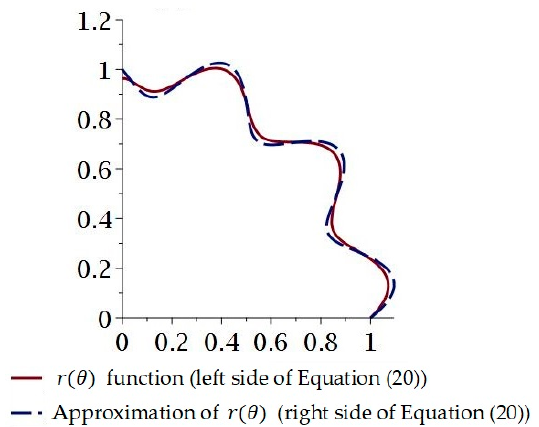
Figure 3. Approximation in series of the function r ( θ ) .